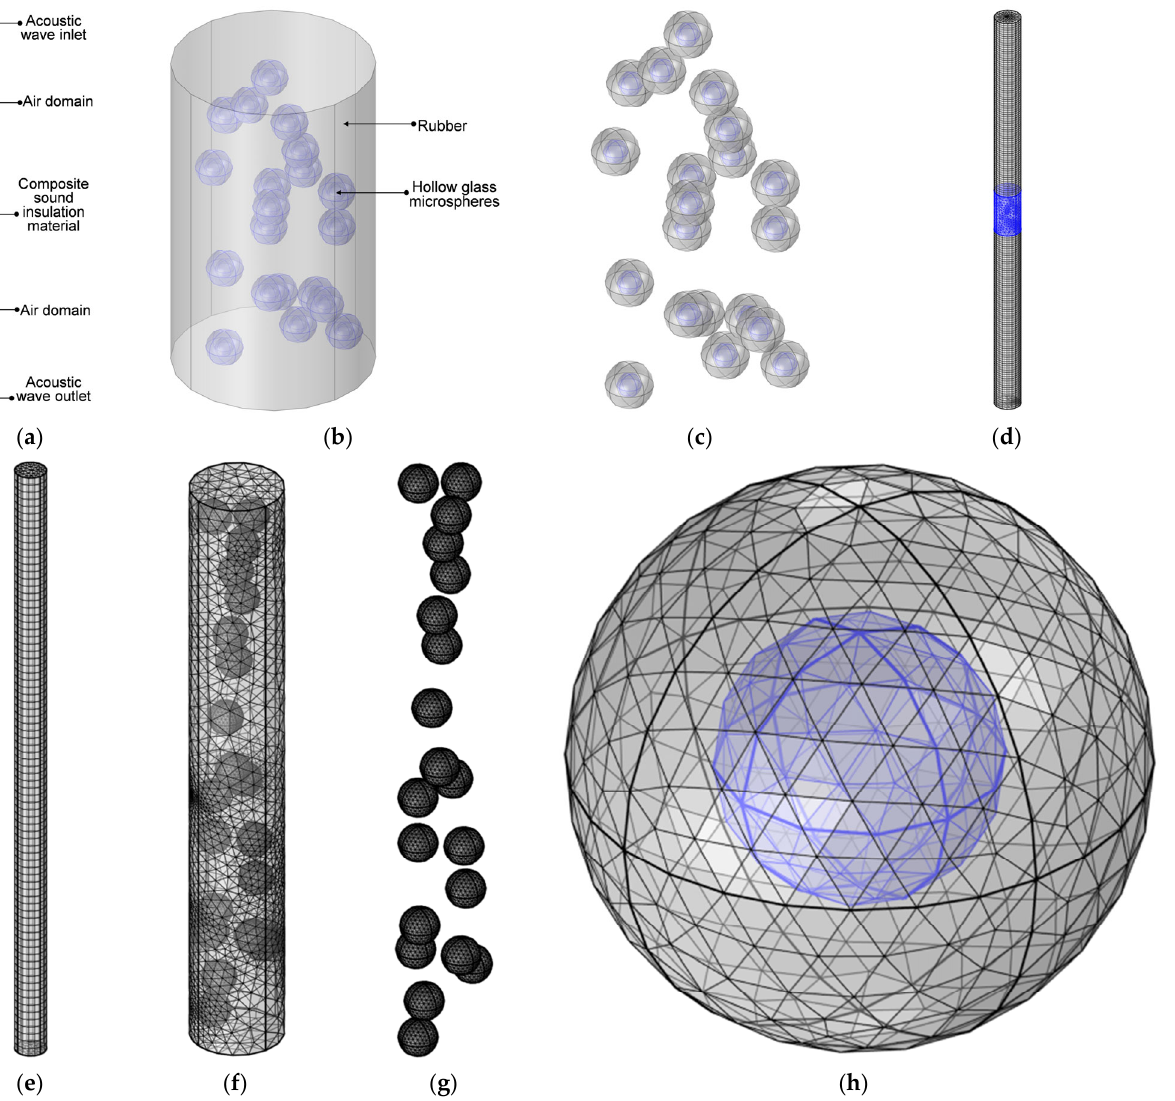
Figure 1. The constructed finite element simulation model. ( a ) General structure of whole model; ( b ) the sound insulator; ( c ) the HGMs; ( d ) the gridded model of whole finite element structure; ( e ) the gridded model of air domain; ( f ) the gridded model of sound insulator; ( g ) the gridded model of the HGMs; ( h ) the gridded model of single HGM. Table 1. Summary of value ranges of the parameters in acoustic finite element simulation